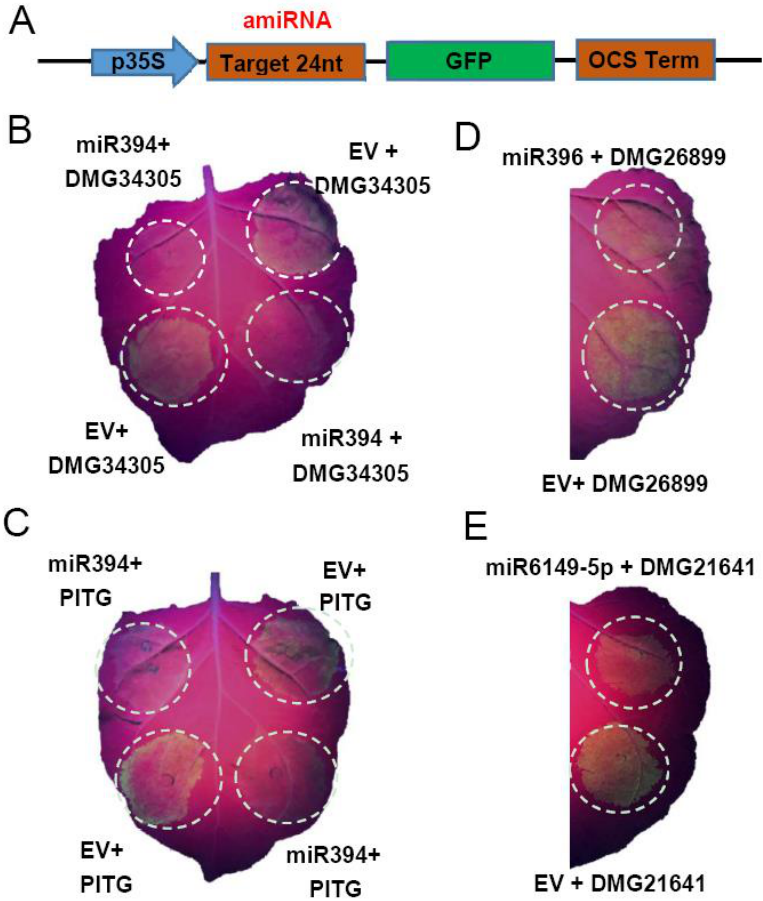
Figure 6. miRNAs suppress the expression of artificial sequences of predicted target genes. ( A ) Schematic expression structure of the amiRNA. Artificial sequence of predicted target gene was fused with green fluorescence GFP . When this structure was co-expressed with miRNA in N. benthamiana , if miRNA could cleave the artificial target sequence, the GFP will not be expressed normally and GFP fluorescence signal would be weak or disappear. ( B ) Sites co-expression of miR394 with its artificial target sequence of PGSC0003DMG400034305 showed weak GFP fluorescence signal compared to co-expression of EV with the artificial target sequence. ( C ) Sites co-expression of miR394 with P. infestans artificial target sequence (PITG) showed weak GFP fluorescence signal compared to co-expression of EV with the target sequence. ( D ) Site co-expression of miR396 and its artificial target sequence of PGSC0003DMG400026899 showed that miRNA396 could suppress the expression of GFP. ( E ) Site co-expression of miR6149-5P and its artificial target sequence of PGSC0003DMG400021641 showed weak GFP fluorescence signal compared to co-expression of EV with the target sequence. Three leaves of each miRNA assay show similar